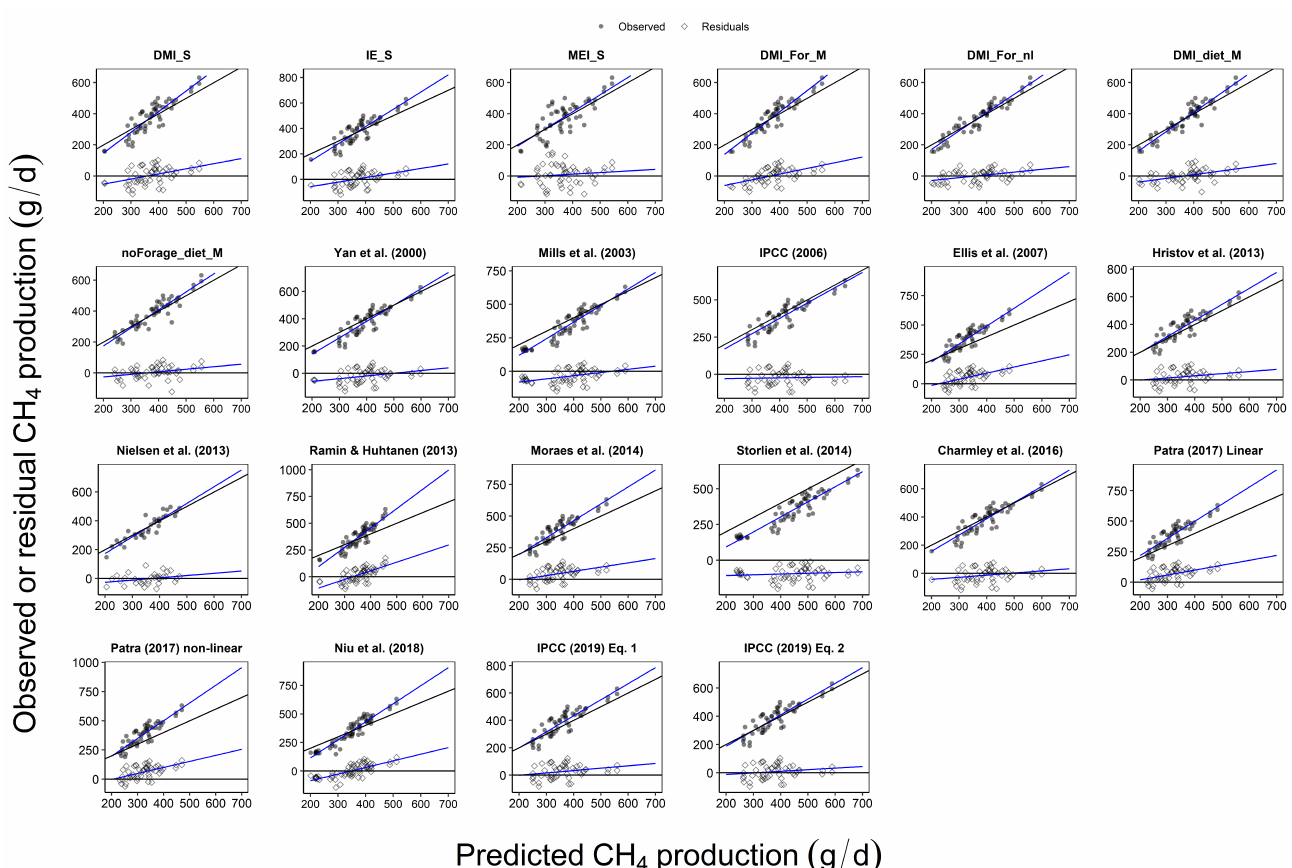
Figure 1. Plots of observed vs. predicted methane (CH 4 ) production (g/d) (illustrated by circles), and residuals (diamond: observed—predicted values) vs. predicted methane production (g/d) (illustrated by diamond shapes) generated from the combined (COM) database ( n = 61) from different model categories and extant equations presented in accordance with Tables 3 and 4. The references interpretations are stated in Table 4. The solid blue lines indicate the relationship between predicted and observed methane production and predicted values and the residuals. The solid black lines represent the line of unity, where y = x